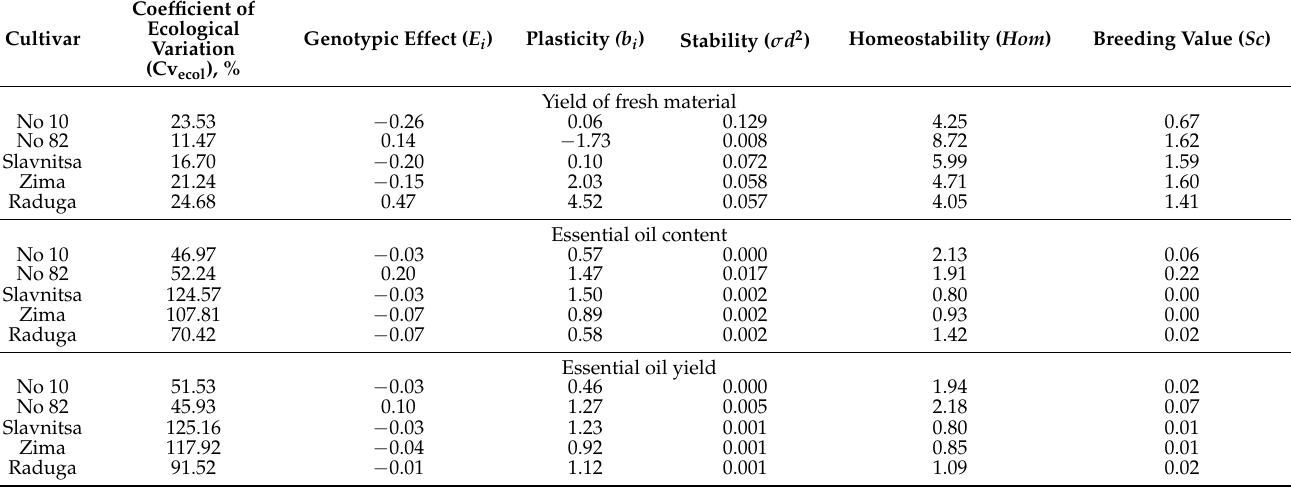
Table 4. Correlation between essential oil yield and its